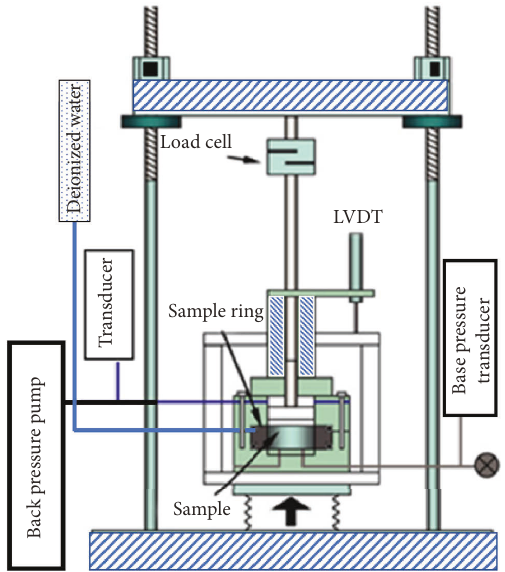
Figure 2: Schematic of oedometer installation used for the bulk swelling/compaction experiments.